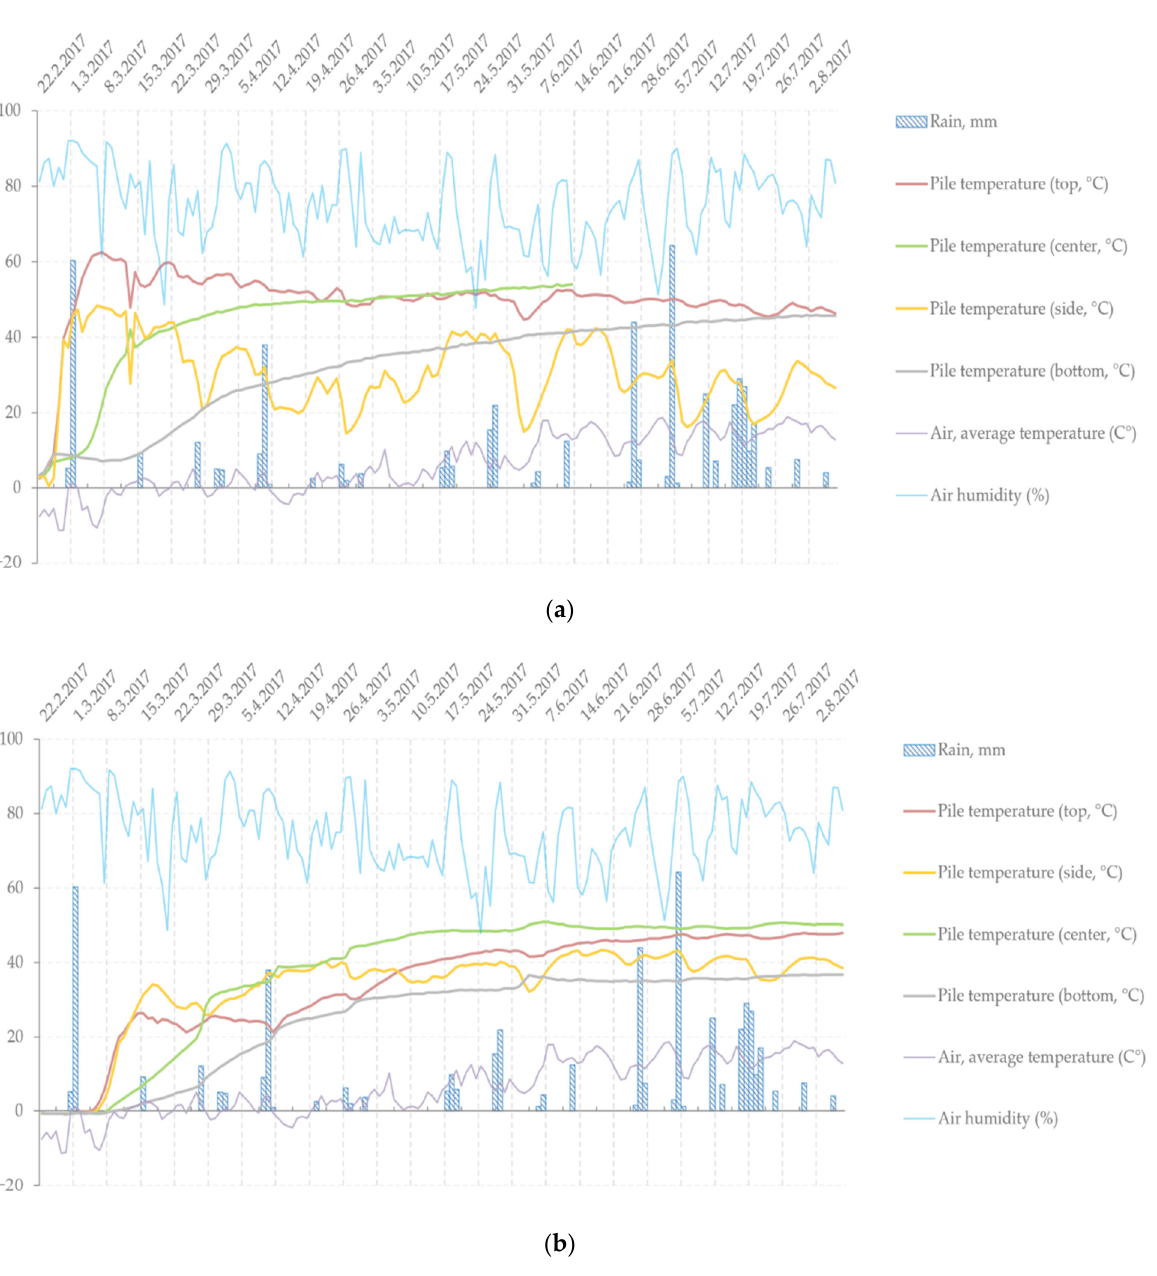
Figure 2. Temperature development inside the non-covered ( a ) and covered ( b ) bark piles accord- ing to the data gathered by thermocouples. The data shown are from sector one after 1 month of